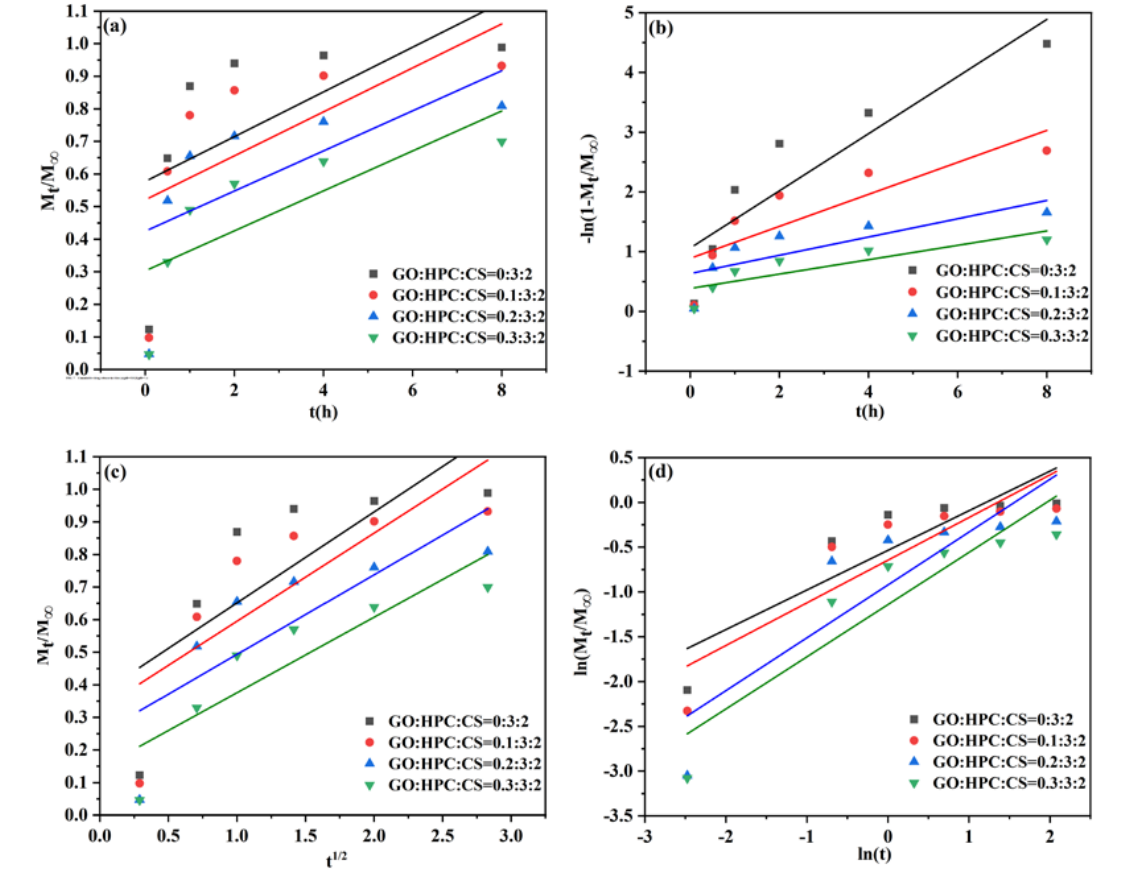
Figure 9. The linear fitted plots of the 5-Fu release from different aerogel with ( a ) zero-order, ( b ) first-order, ( c ) Higuchi, and ( d ) Korsmeyer–Peppas models at pH = 5.0.